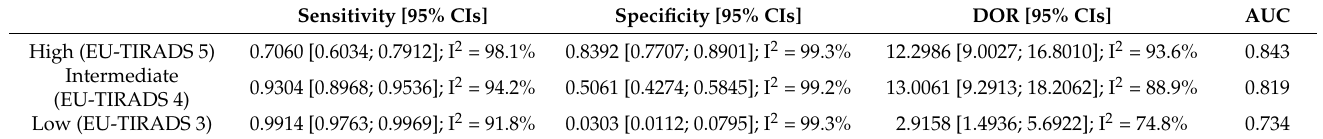
Table 4. Diagnostic efficacy and the ROC curves of EU-TIRADS categories.